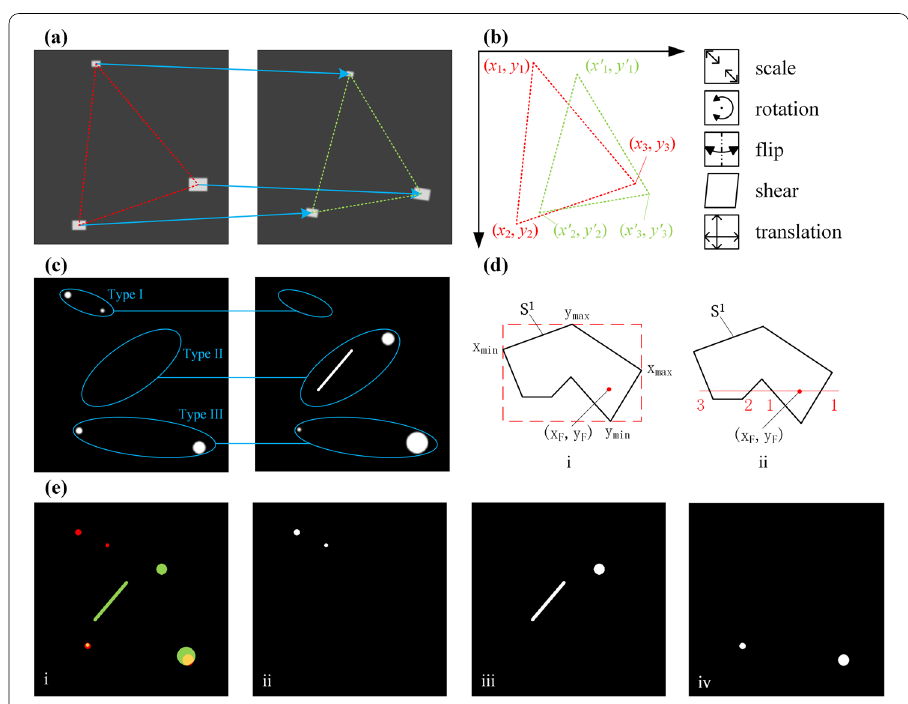
Fig. 7 Algorithm schematic diagrams for image registration and fusion. a Diagrams of feature points selection from two images to be registered (scattering image on the left, fluorescence image on the right). b Diagrams of affine transformation model. c Simulation images of three types of defects (scattering image on the left, fluorescence image on the right). d Diagrams of contour overlap judgment: i. coarse judgment; ii. fine judgment. e Results of image fusion: i. superposition image; ii. type I defects (SDs); iii. type II defects (covered SSDs); iv. Type III defects (extended